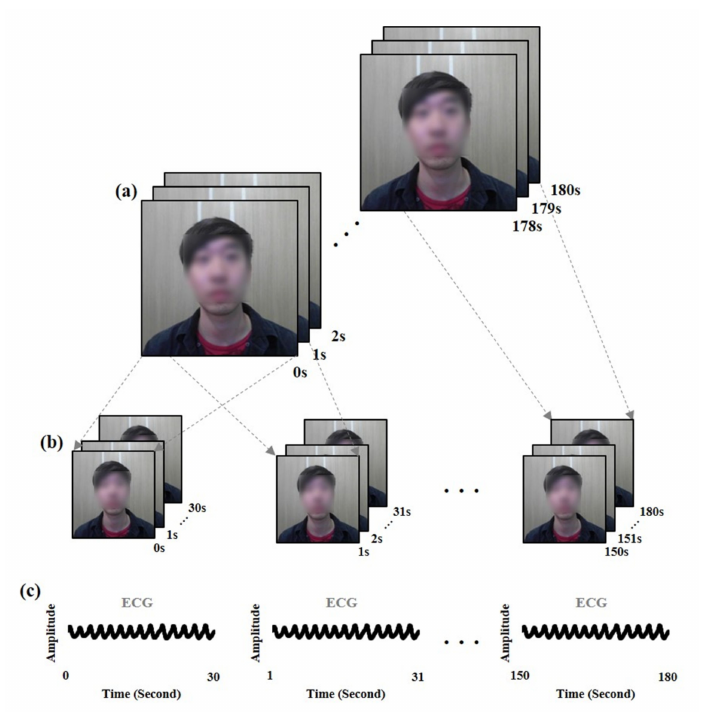
Figure 5. Overview of signal segmentation by sliding window. ( a ) Facial video recorded for 3 min, ( b ) facial video segmented by sliding window (window size = 30 s, interval size = 1 s), ( c ) ECG signal corresponding to the segmented facial